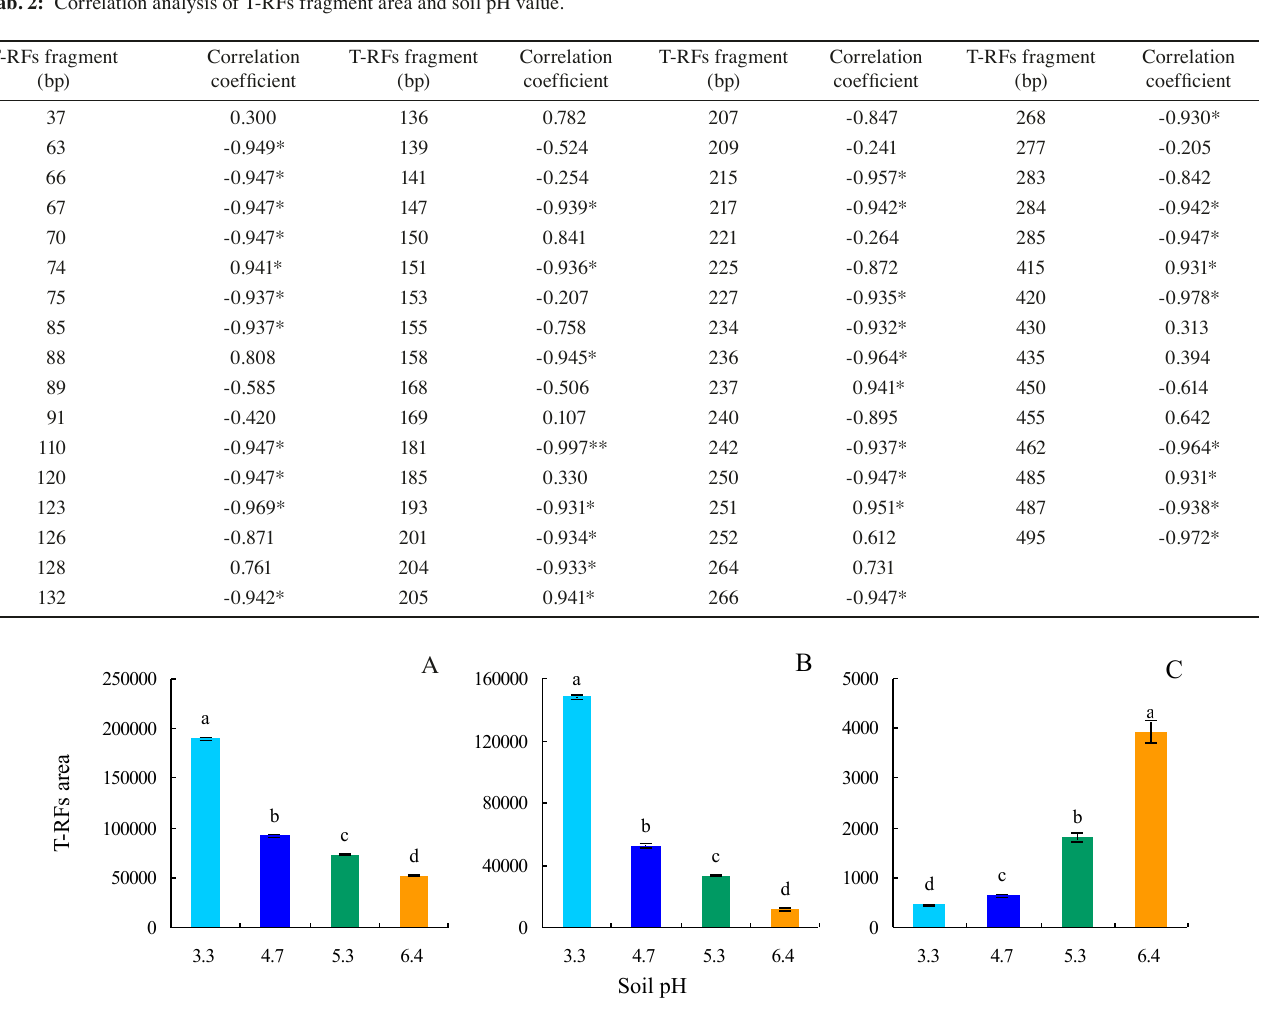
Fig. 2: The area of T-RFs in soils with different pH values was significantly correlated with pH values. Note: A: T-RFs significantly correlated with pH; B: T-RFs significant negative correlation with pH value; C: T-RFs significantly positively correlated with pH value. The lowercase letters represent a significant level at P <